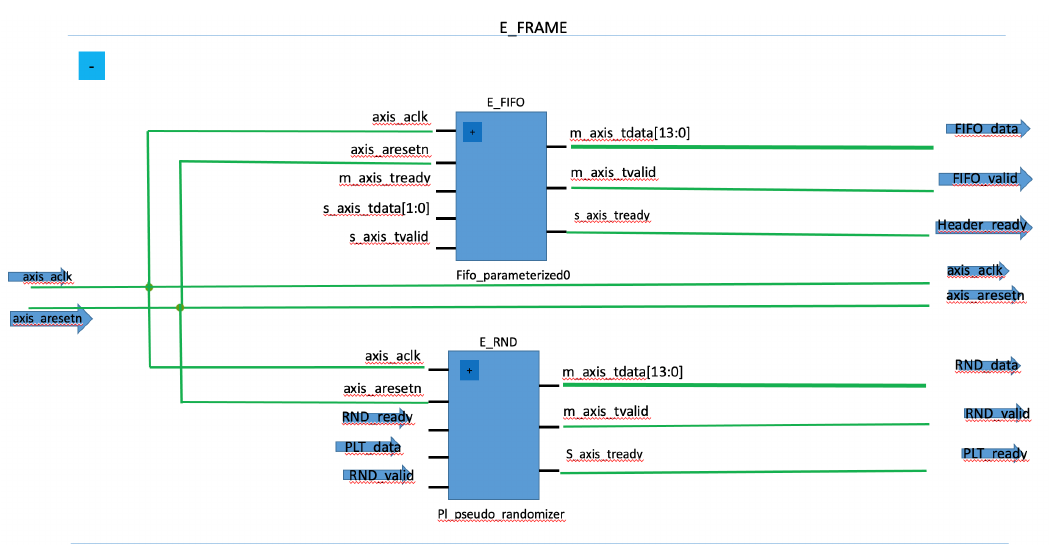
Figure 17. Part I—physical layer frame RTL block diagram.